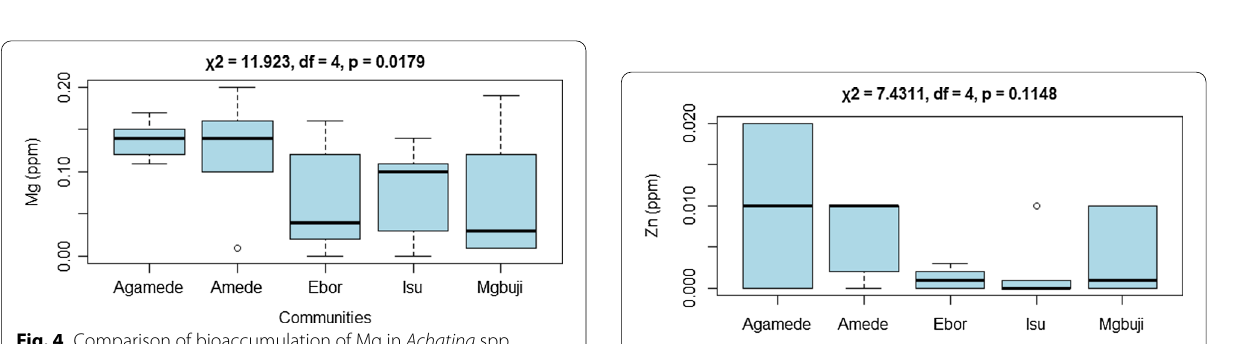
Fig. 4 Comparison of bioaccumulation of Mg in Achatina spp amongst sampled communities